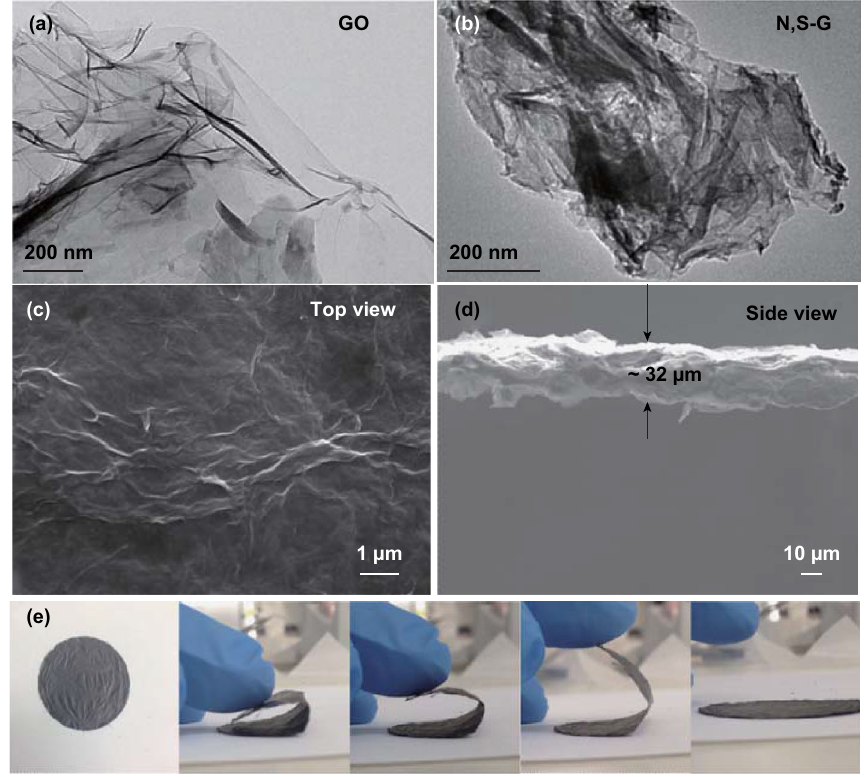
Fig. 4 TEM images of a GO and b N,S-G. SEM images of N,S-G membrane in: c top view, d side view, and e the free-standing N,S-G